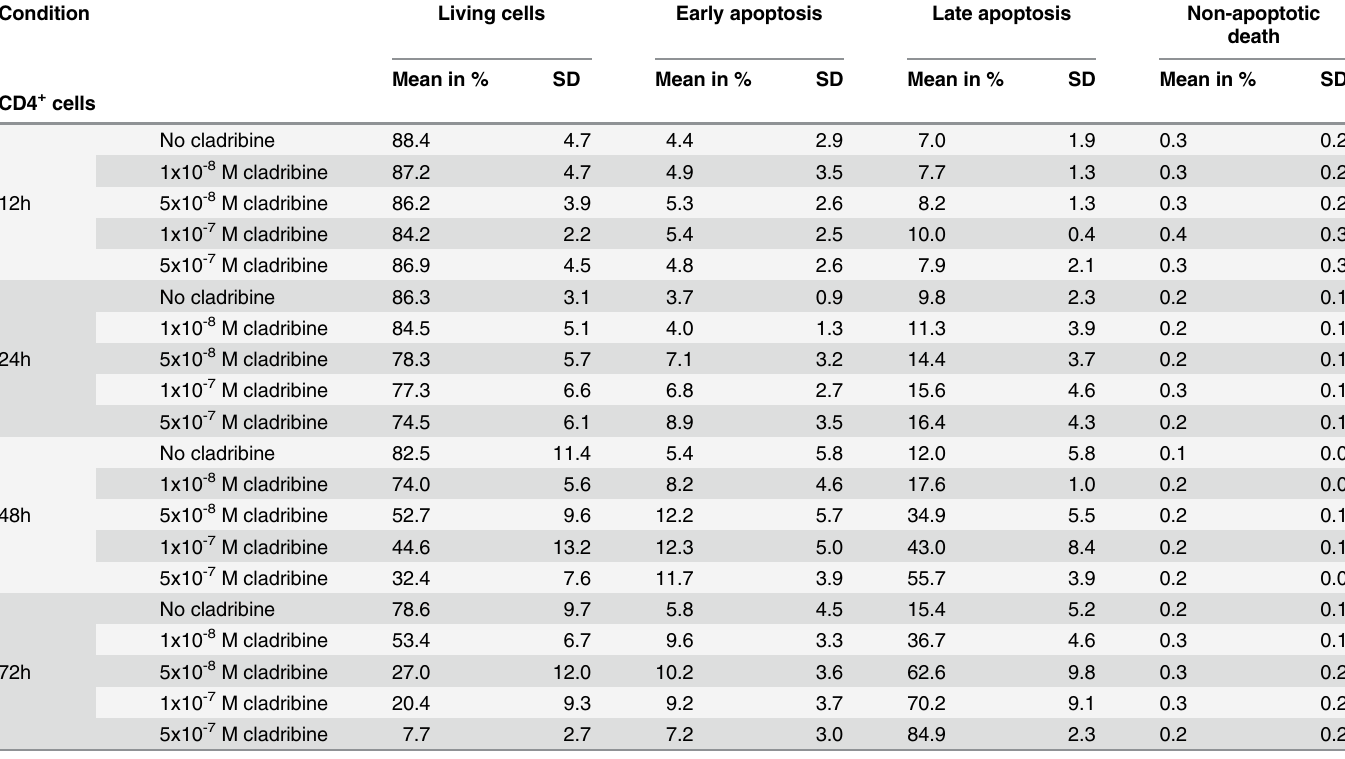
Table 2. Apoptosis of stimulated CD4 + cells caused by cladribine in vitro . Condition Living